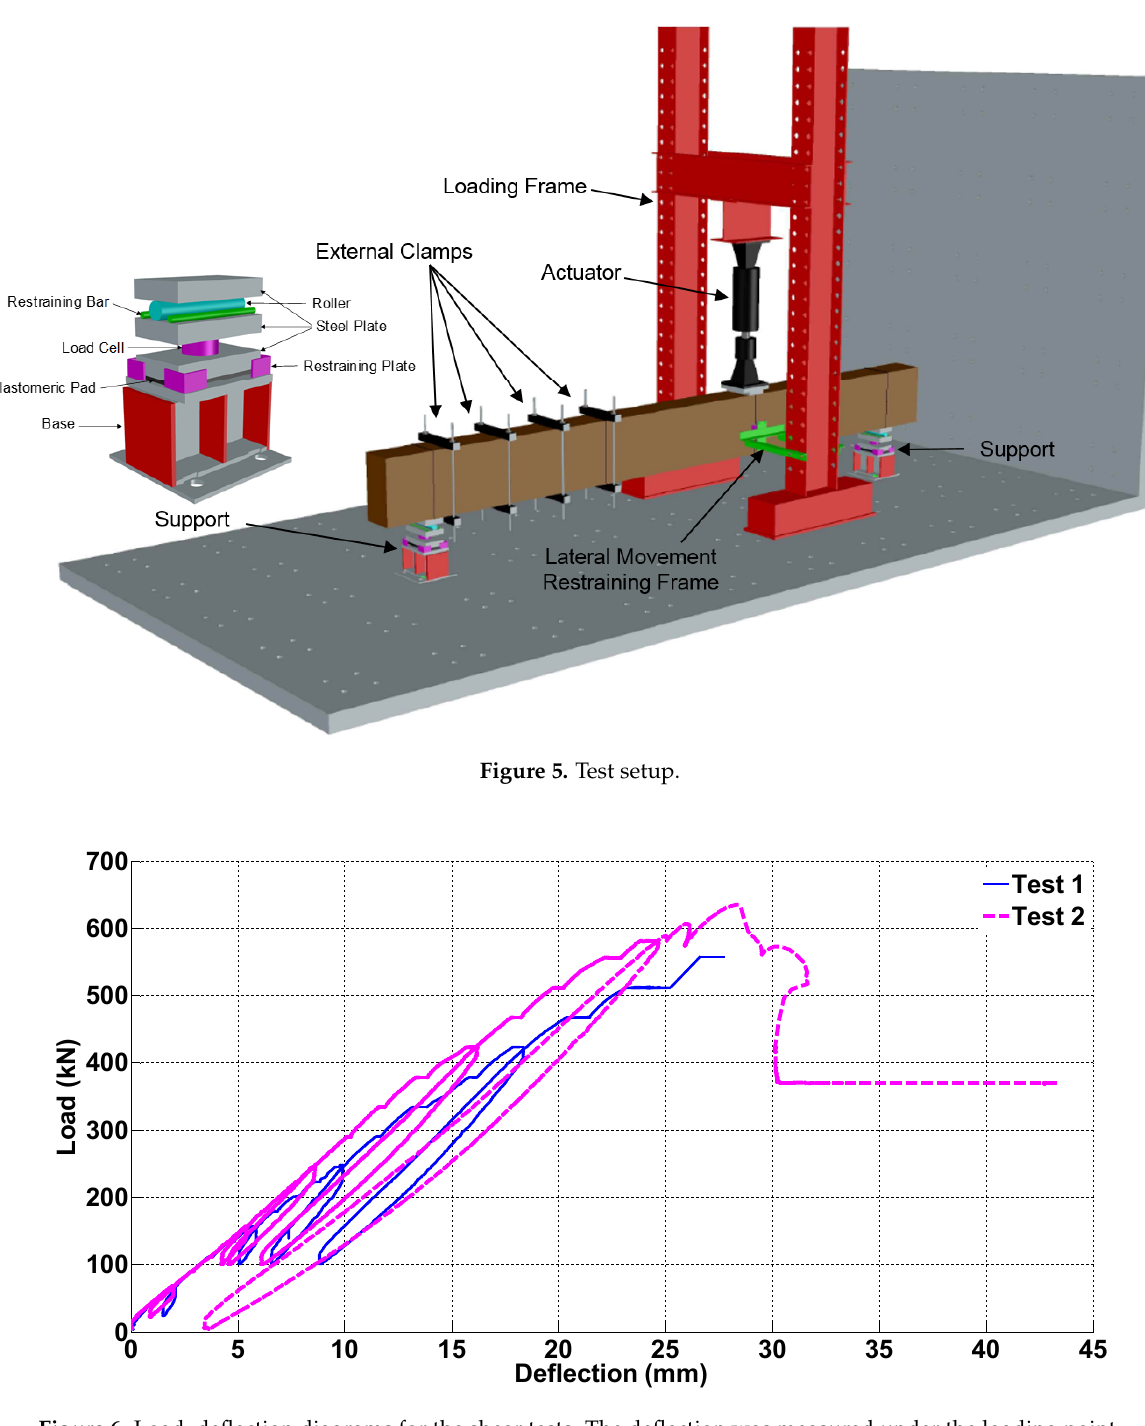
9 of 23 Figure 4. As built dimensions of the full-scale beam, loading and support locations and instrumentation (all dimensions are in mm).